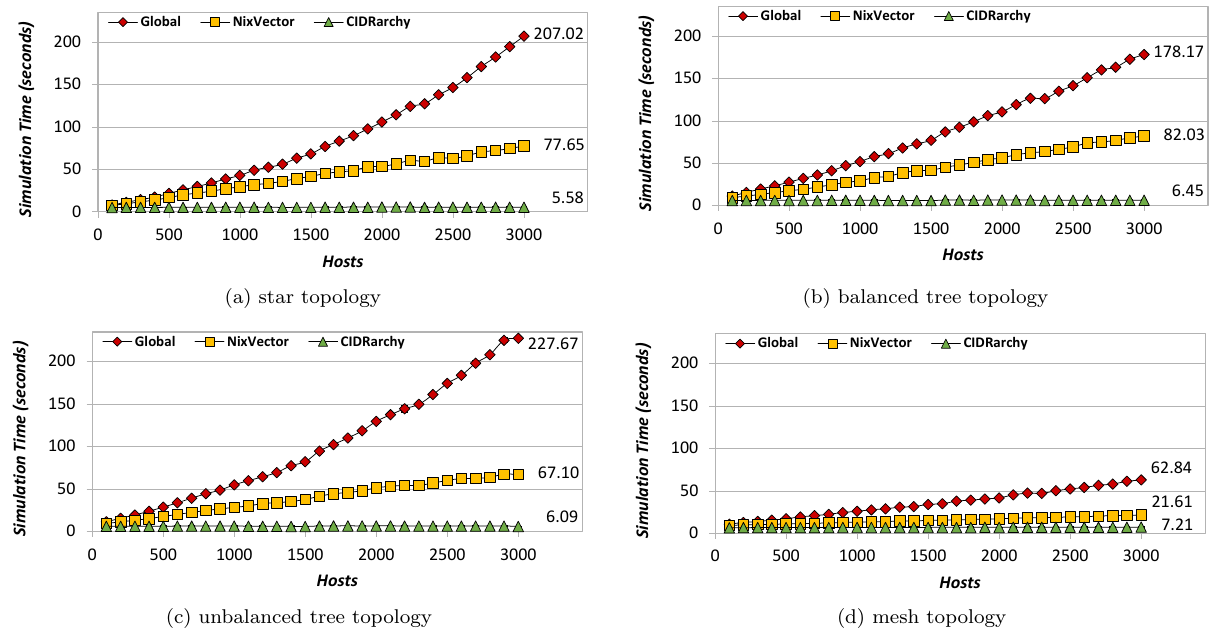
Figure 5: Simulation time required by CIDRarchy, Ipv4GlobalRouting and Ipv4NixVectorRouting routing protocols to transmit 150000 packets, each packet having a size of 1000 bytes, using OnOffApplication and PacketSink applications, in star, balanced tree, unbalanced tree, and mesh scenarios with an increasing number of